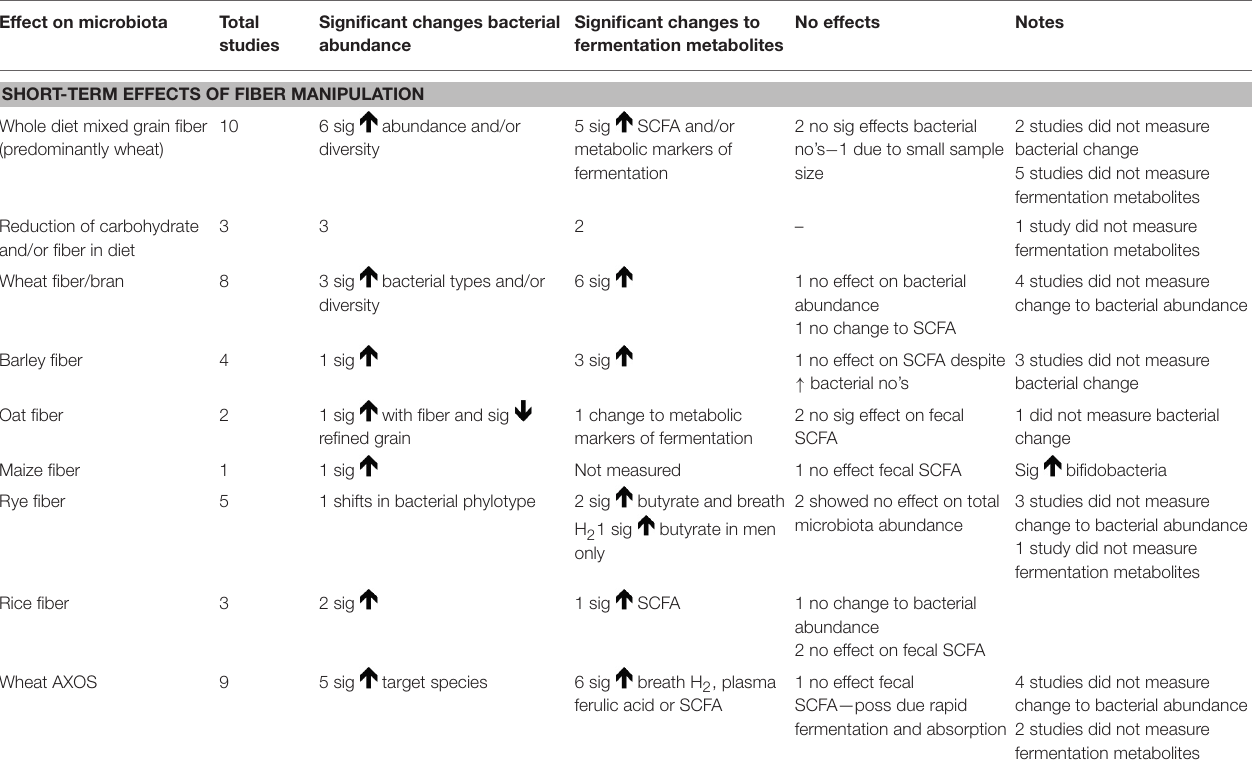
TABLE 3 | Summary of findings for the short-term effect of increasing cereal fiber on gut microbiota outcomes in health